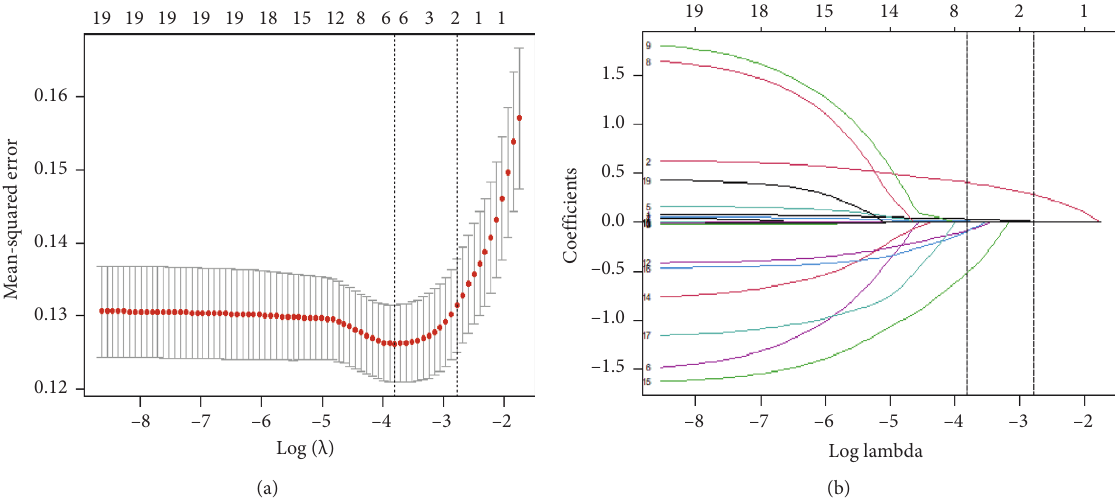
Figure 1: Variable selection using the LASSO binary regression model. Notes: optimal parameter (lambda) selection in the LASSO model used tenfold cross-validation via minimum criteria. The partial likelihood deviance (binomial deviance) curve was plotted versus log (lambda). Dotted vertical lines were drawn at the optimal values by using the minimum criteria and the 1-SE of the minimum criteria (the 1- SE criteria). LASSO coefficient profiles of the 19 features. A coefficient profile plot was produced against the log (lambda) sequence. Vertical line was drawn at the value selected using tenfold cross-validation, where optimal lambda resulted in six features with nonzero coefficients. LASSO, least absolute shrinkage and selection operator; SE, standard error. Table 2: Risk factors associated with T2DM among overweight and obesity population by Cox proportional hazards regression model